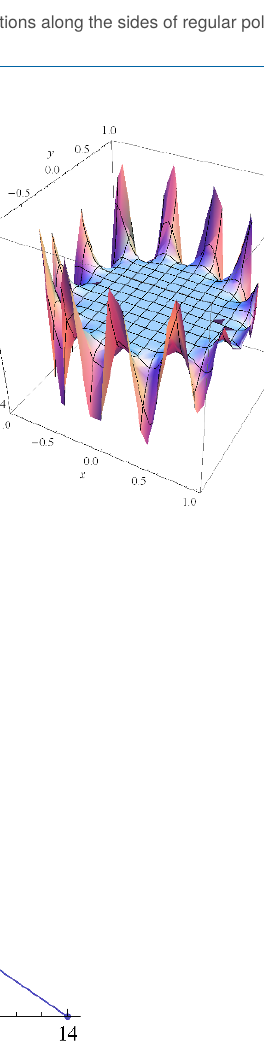
Figure 4. First example: errors. x -axis: degree of interpolating polynomial. y -axis: relative L